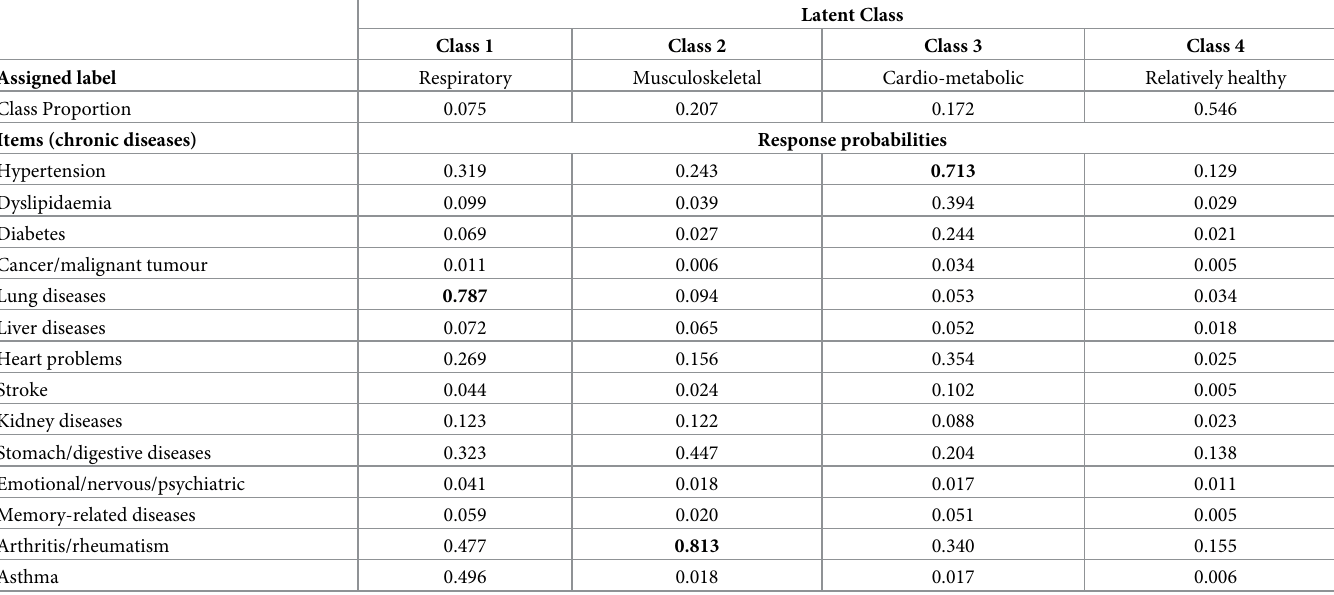
Table 2. Class proportions and class-specific probabilities from a four-latent-class model of chronic